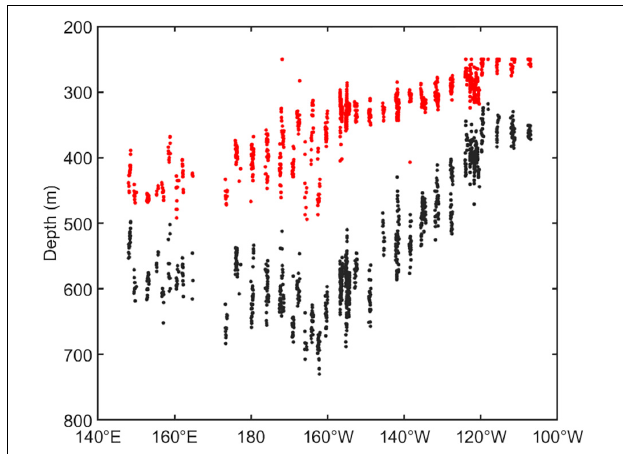
FIGURE 6 | The vertical distribution of DSLs in daytime along the longitudinal gradient. The dots showed the UBD (red dots) and CM (black dots).